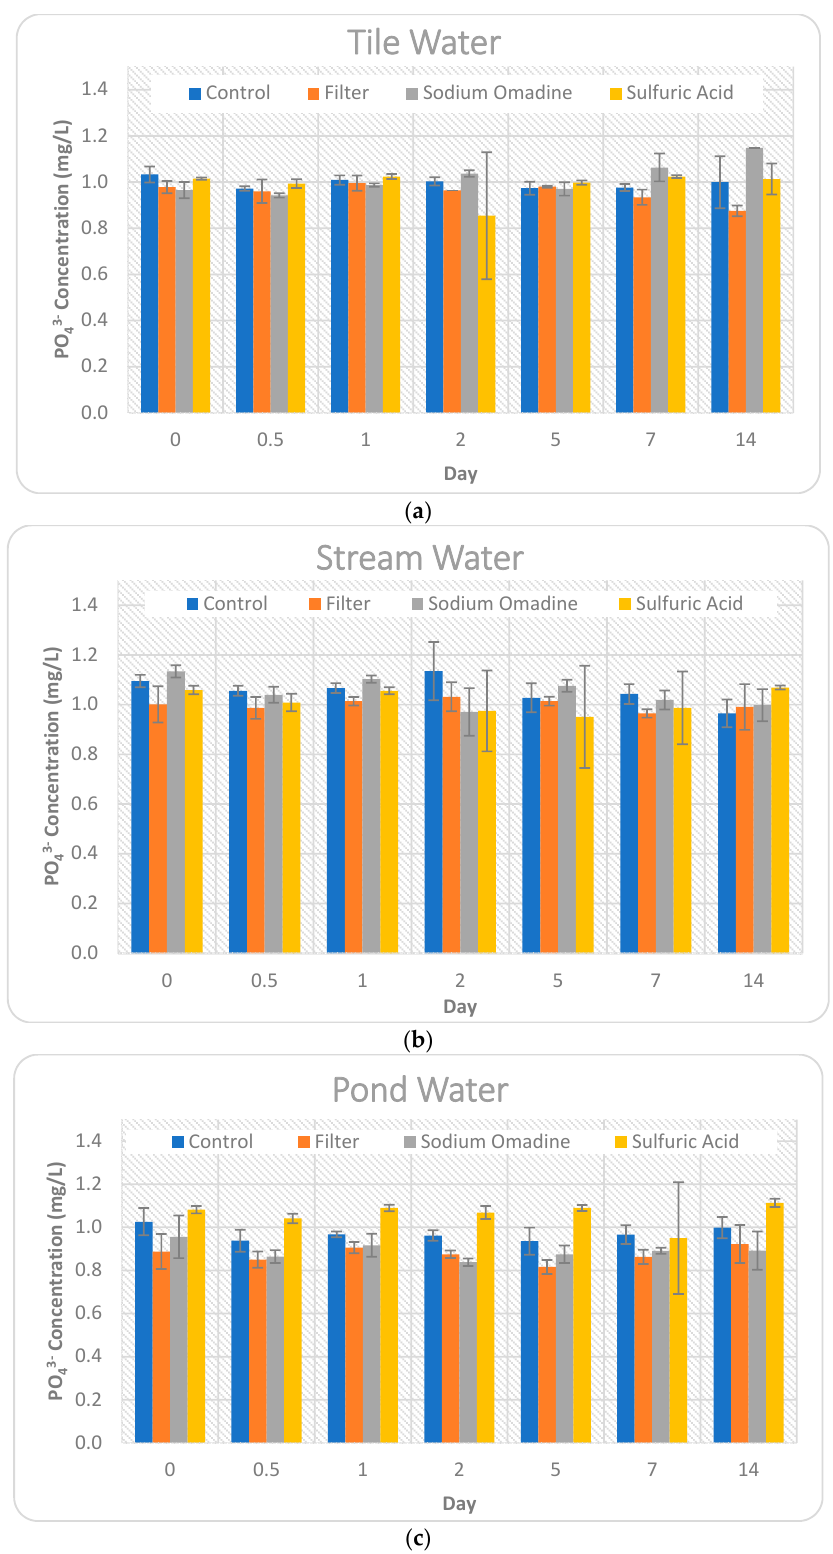
Figure 4. Comparison of the impact of the four preservation methods on orthophosphate concentration for Day 0–14. Error bars represent +/ − one standard deviation from the mean. ( a ) Tile water; ( b ) Stream water; ( c ) Pond water.